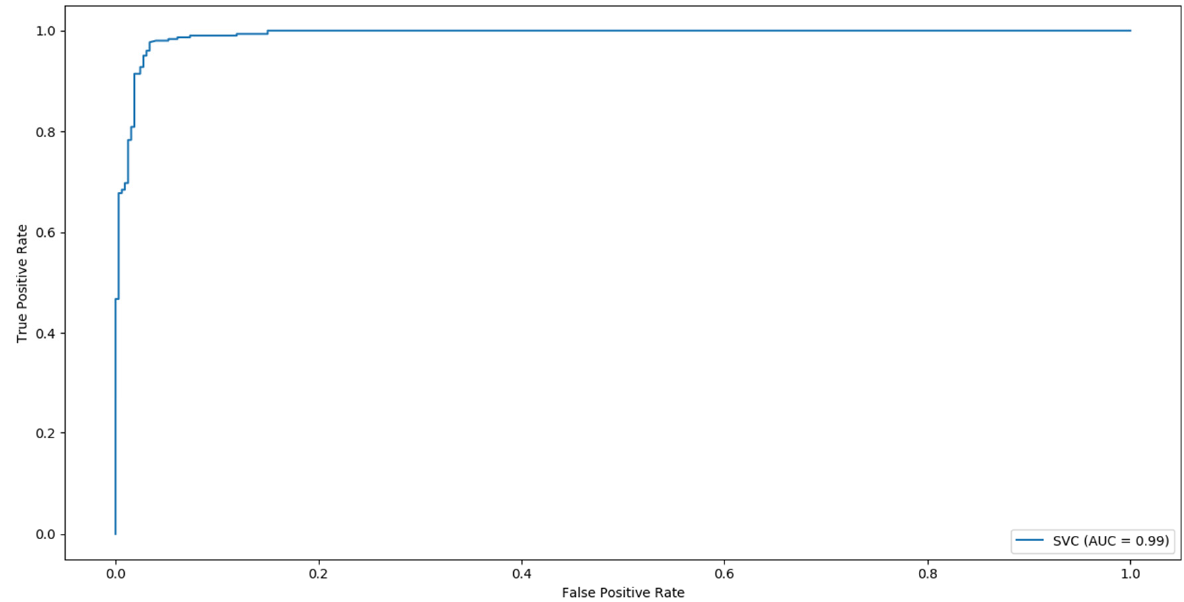
Figure 3. Receiver operating characteristic curve for the two-class classifier based on the DeepFace model . Table 4. Two class classification results for test sets of patients with diseases that were removed from the training data. Disease Removed from Training